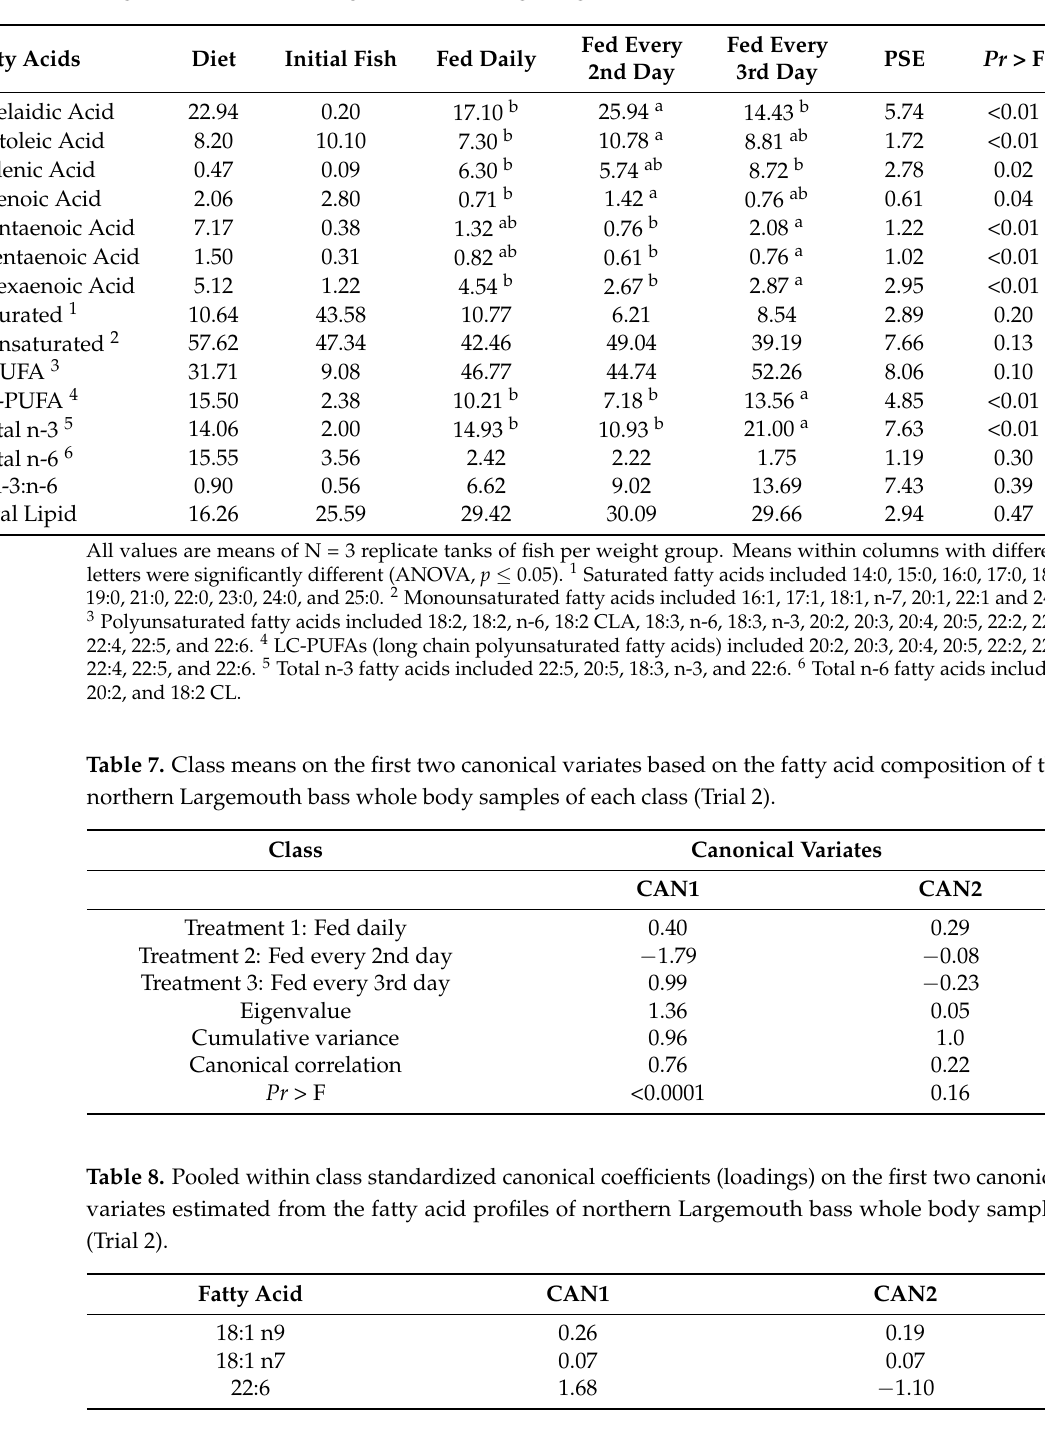
Table 6. Selected fatty acid composition of the diet and whole-body samples (% of total fatty acids by weight) from northern Largemouth bass fingerlings (Trial 2).